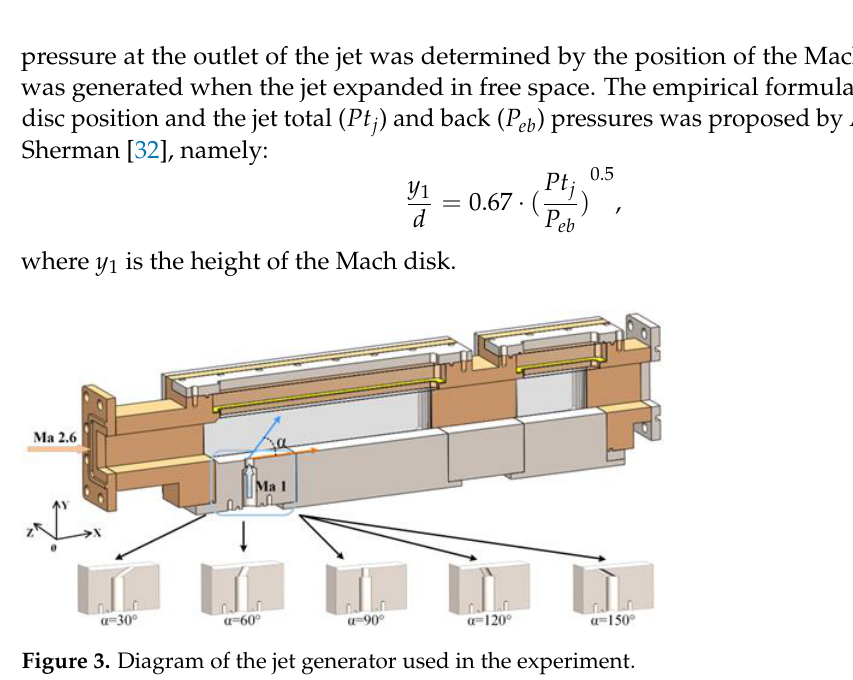
Figure 3. Diagram of the jet generator used in the experiment.